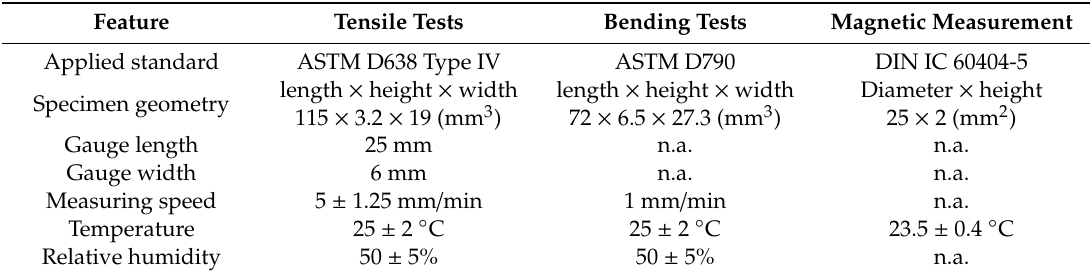
Table 1. Specimen geometries and selected test